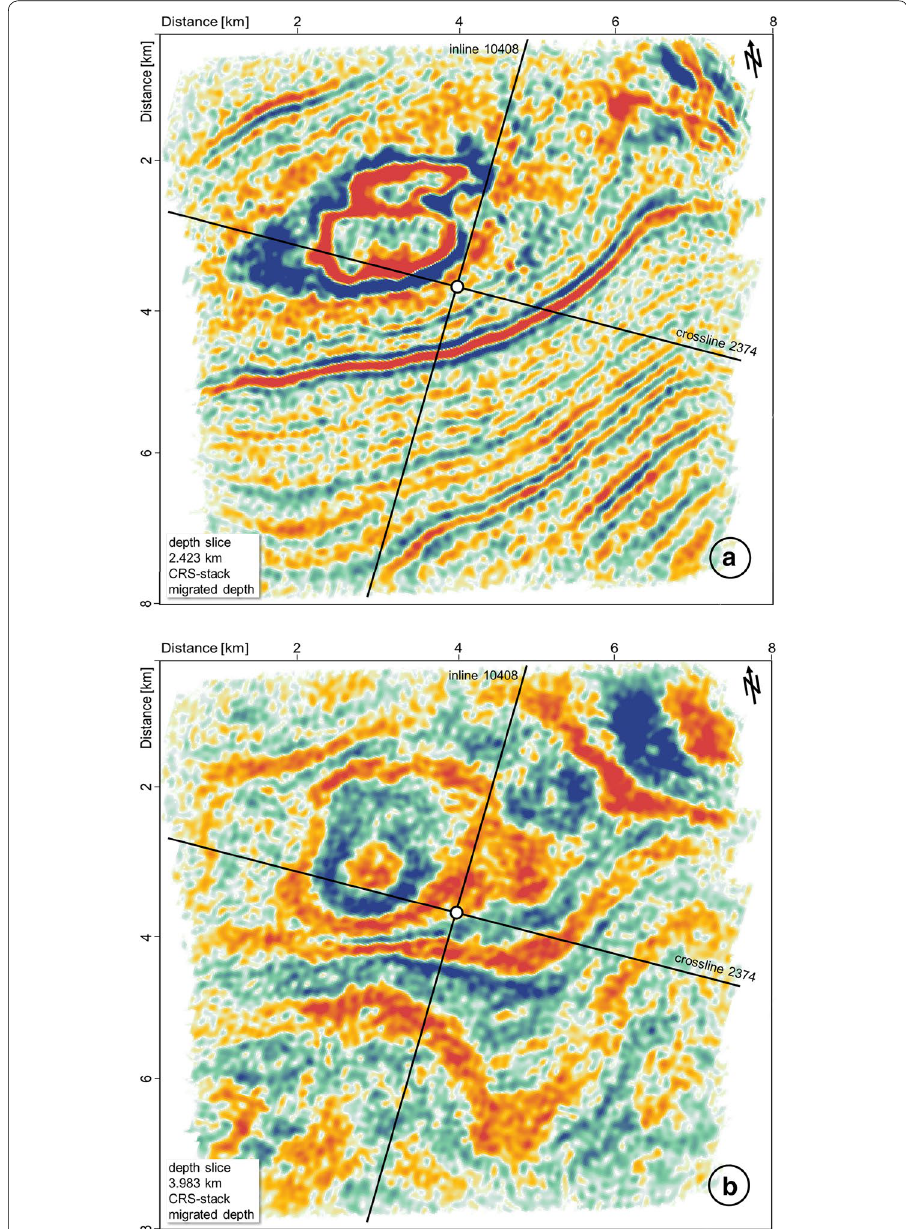
Fig. 6 Depth slices of CRS-stacked and post-stack time-migrated depth-converted seismic volume (black lines—locations of inline and crossline sections shown in Fig. 5; white filled circle—surface location of borehole, c.f. Fig. 3). The displays at 2.423 km ( a ) and 3.983 km ( b ) depth emphasize top Zechstein (reflector X1) and Rotliegend (reflector R2) structures, respectively (for deviations check vertical sections in Figs. 4